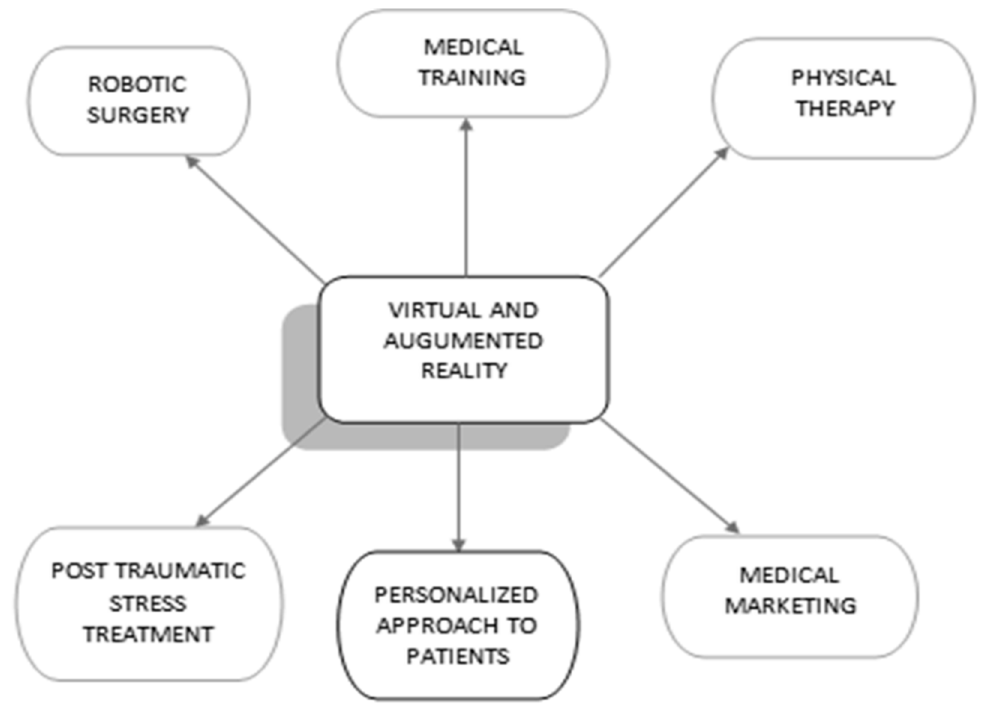
Figure 8. Virtual reality deployment in medical field applications. Table 6. Review of VR/AR/MR technologies’ deployment in allied medical field